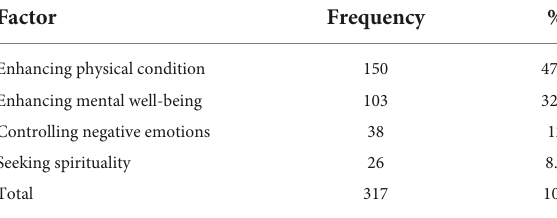
TABLE 1 Kaiser–Meyer–Olkin (KMO) and Bartlett’s test.